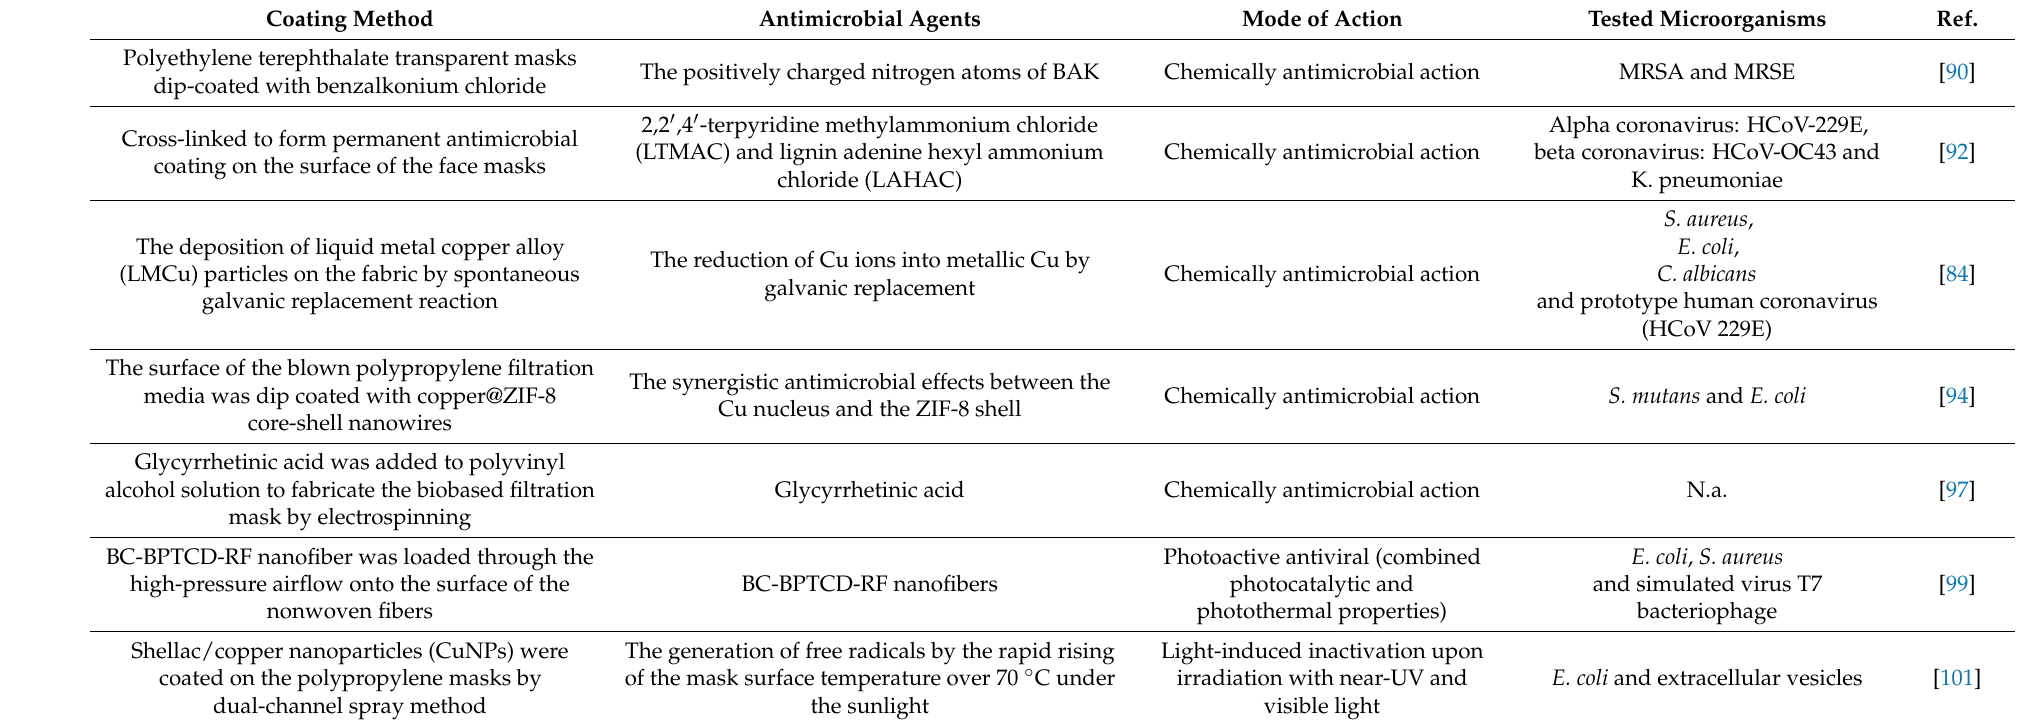
Table 2. Strategies for the fabrication of antimicrobial